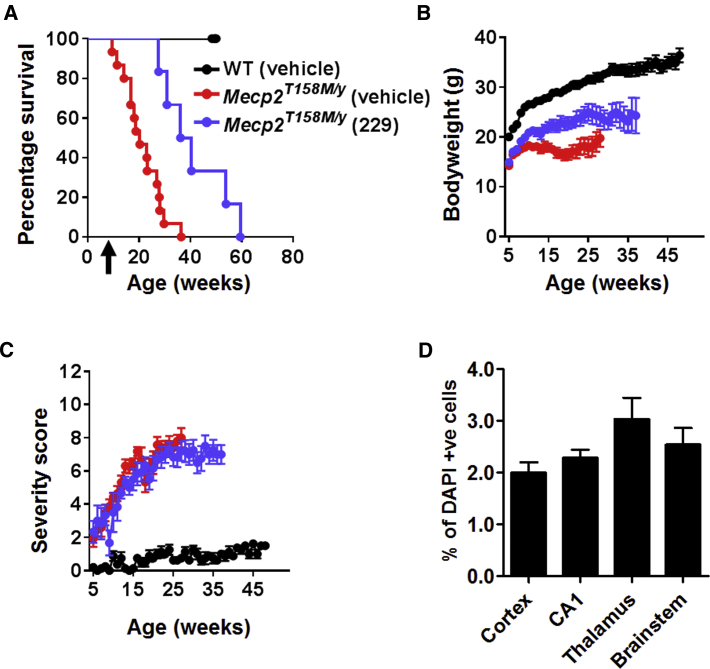
Improved Survival and Body Weight of Mecp2T158M/Y Mice after Systemic Delivery of the First-Generation Vector(A) Survival plot for treated Mecp2T158M/y mice. Arrow indicates age at injection. (B and C) Plots of (B) body weight and C) aggregate severity score, respectively, for Mecp2T158M/y mice treated with 1 × 1012 vg per mouse of first-generation vector and control groups (Mecp2T158M/y and WT) treated with vehicle. Data presented as mean ± SEM. (D) Transduction efficiency in the brain of treated mice (Myc-positive nuclei as a proportion of DAPI-positive nuclei; n = 3 mice).